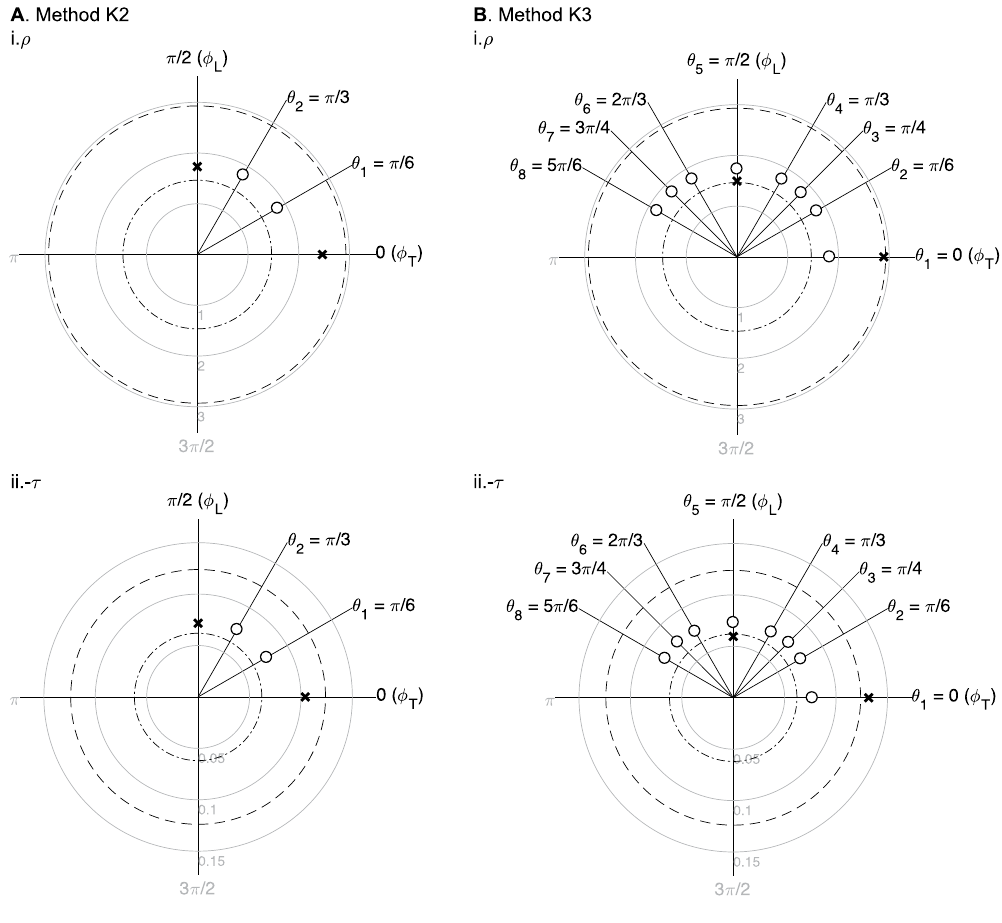
Figure 4. Numerical simulation results using methods K2 ( A ) and K3 ( B ). The estimated impedivity in longitudinal (L) and transverse (T) directions ˆ κ (shown in crosses) were calculated from M = 10 averaged L { ,T} apparent impedivity κ θ ( ) measurements (shown in circles), with d = 1, … , D the measurement angles and d a ˆ interelectrodes’ distance p = 8.6. Method K2 ( D = 2): ρ = . ˆ 1 73 L 0 13 T τ = − . Ω m. The true longitudinal and transverse resistivity (i) and reactivity (ii) are plotted in in dash-dot and dashed circumferences, ρ L = 1.46 Ω m, ρ T = 2.93 Ω m, τ L = − 0.06 Ω m and τ T = − 0.12 Ω m, respectively. The reactivity is shown − τ as a convention. The units of impedivity are Ω m.